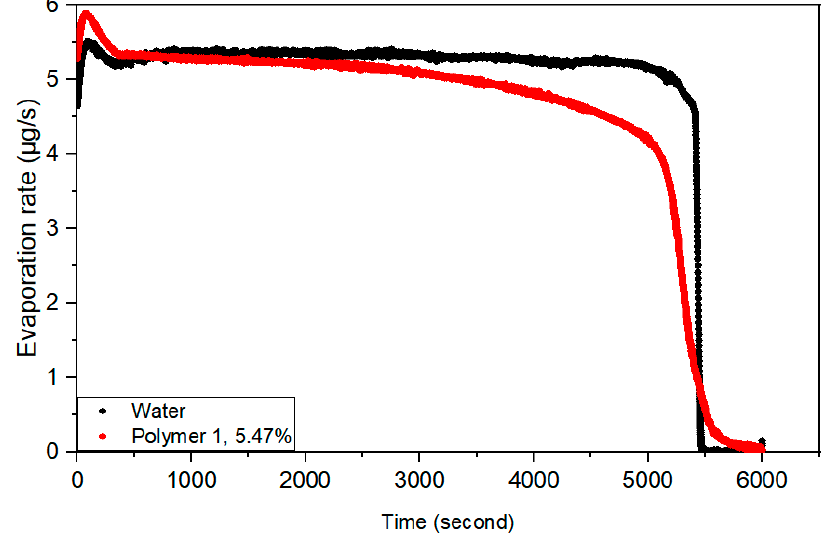
Figure 4. Evaporation rate of 5.47% Polymer 1 solution and deionized water.